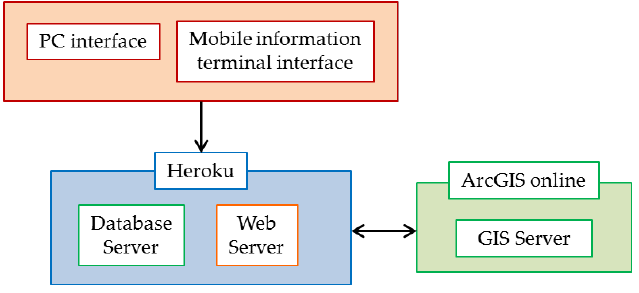
Figure 2. System operating environment.